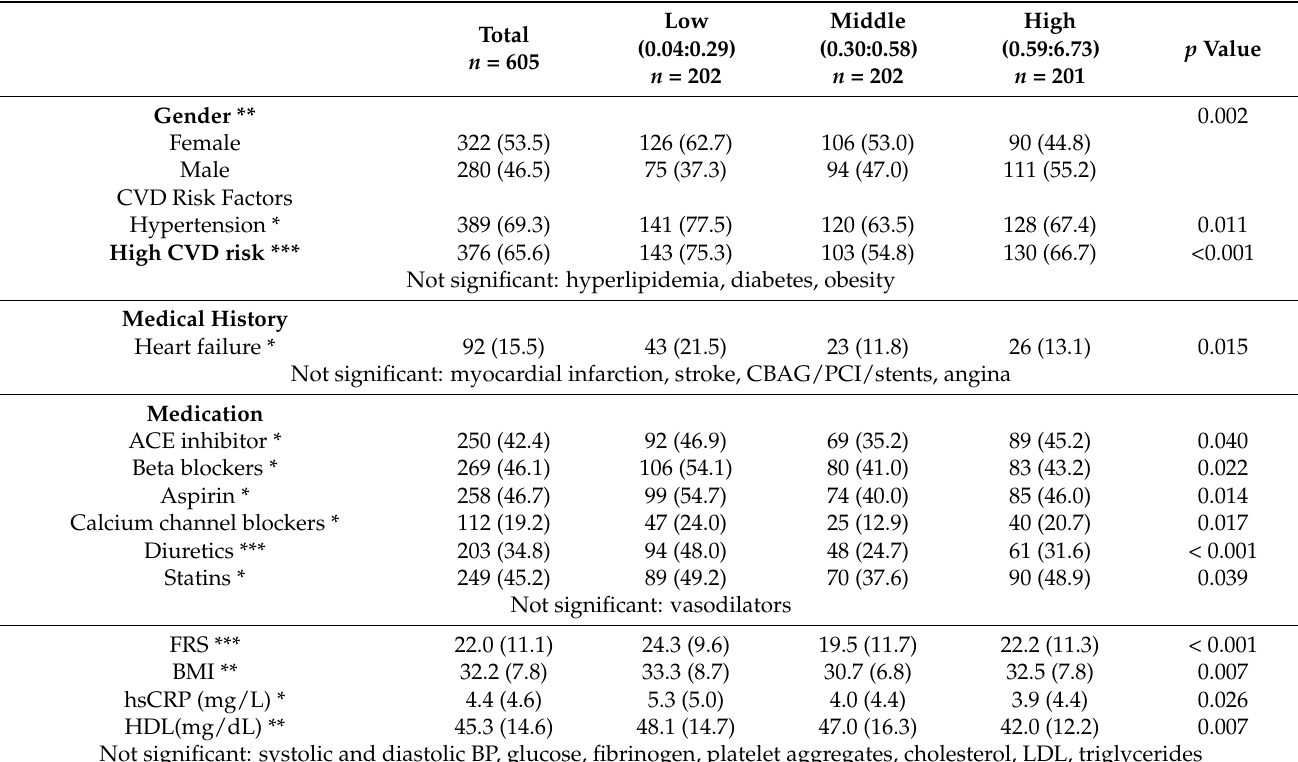
Table 1. Characteristics of Study Participants Stratified by Urinary Levels of Carnosine.